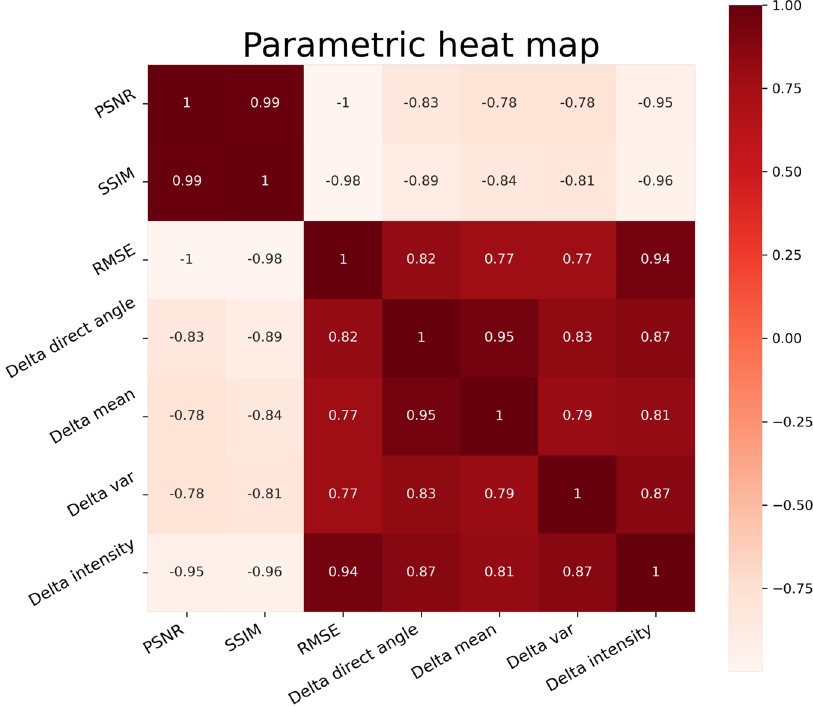
Fig. 11 Correlations of PSNR, SSIM, RMSE, Δ α , Δ μ , Δ σ , Δ A in a heatmap. On one side, we quantitively analyze the correlations between these metrics; on the other side, we intend to formulate a new universal metric (Betas) that better evaluates the performance with a bigger